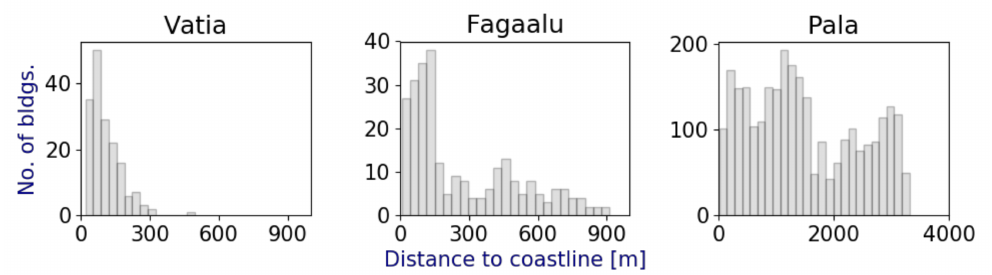
Figure 7. Histograms showing the distribution of straight-line distances from each building within the developed study watersheds to the nearest portion of the